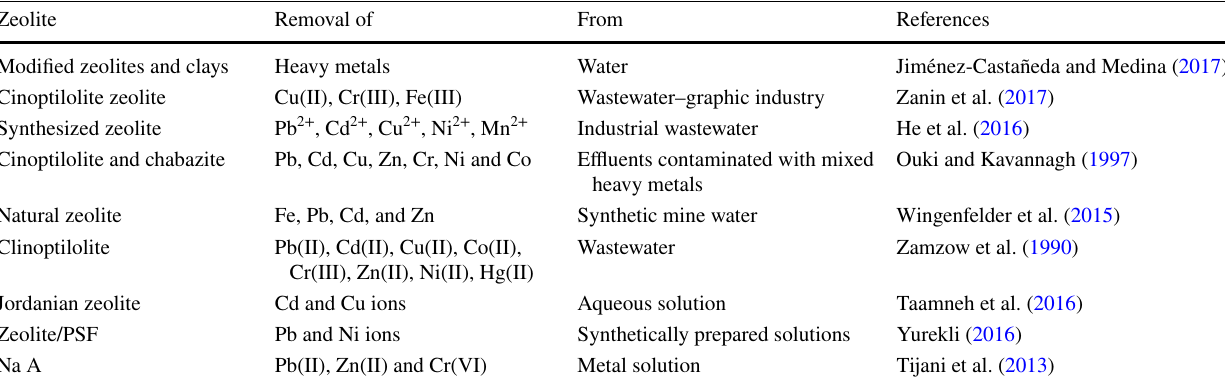
Table 8 Summary of the use of zeolites for water treatment by adsorption